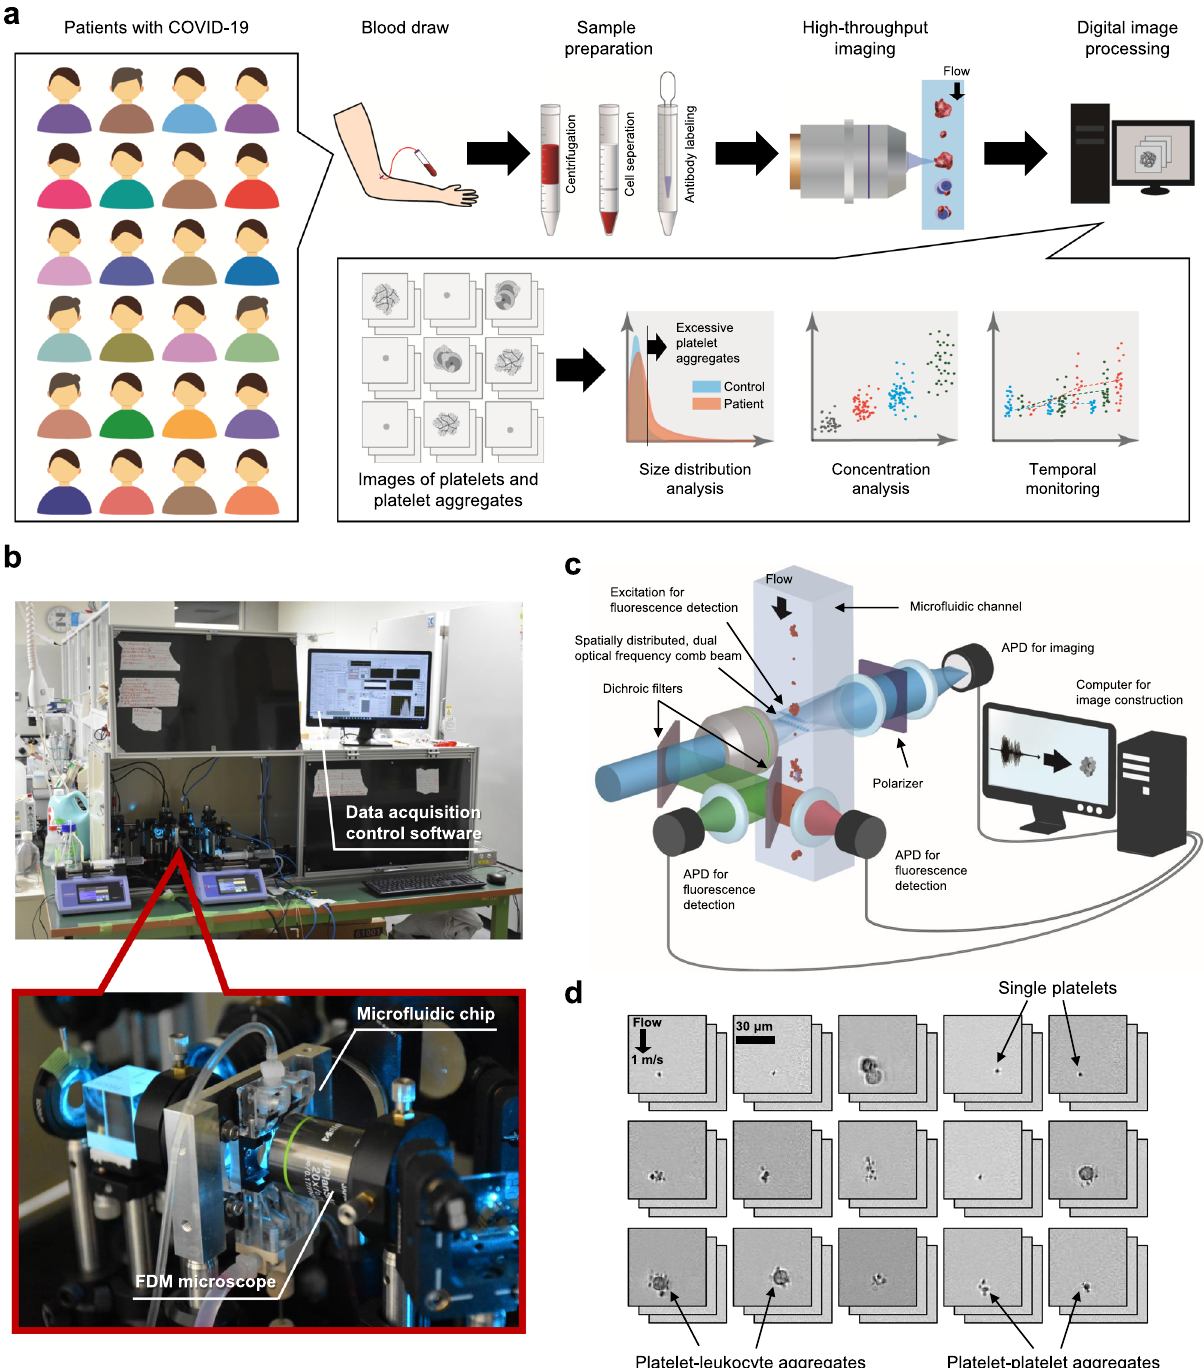
Fig. 1 Massive image-based pro fi ling of circulating platelets and platelet aggregates at single-cell resolution. a Experimental work fl ow consisting of blood draw, sample preparation, high-throughput imaging, and digital image analysis. b Pictures of the FDM microscope on the micro fl uidic chip installed in the Department of Clinical Laboratory at the University of Tokyo Hospital. The inset shows an enlarged view of the micro fl uidic chip with the FDM microscope. c Schematic of the FDM microscope for high-throughput, blur-free, bright- fi eld image acquisition. APD: avalanche photodetector. d Typical bright- fi eld images of single platelets and platelet aggregates acquired by the FDM microscope. For information about data reproducibility, see “ human subjects ” and “ statistical analysis ” in the Methods section for